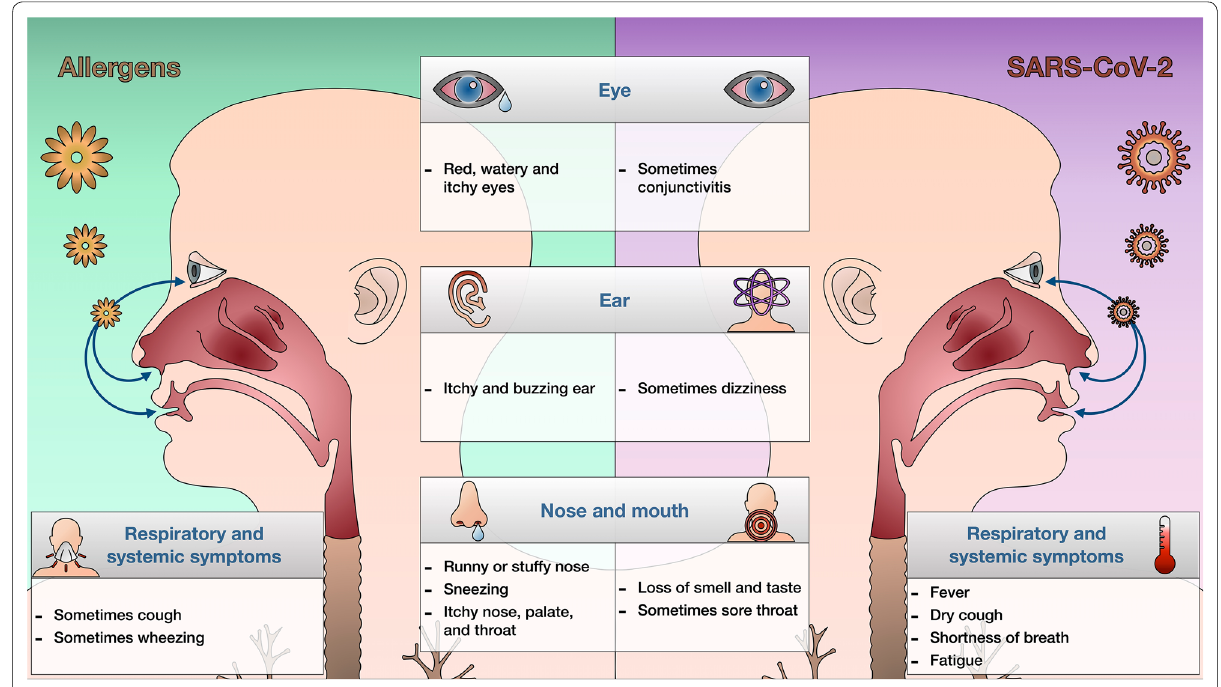
Fig. 1 Differential diagnosis of allergic airway diseases and SARS-CoV-2